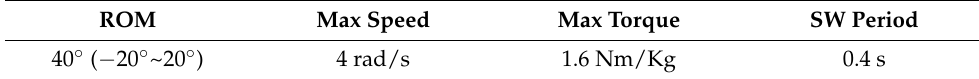
Table 1. Performance metrics of the prosthesis.